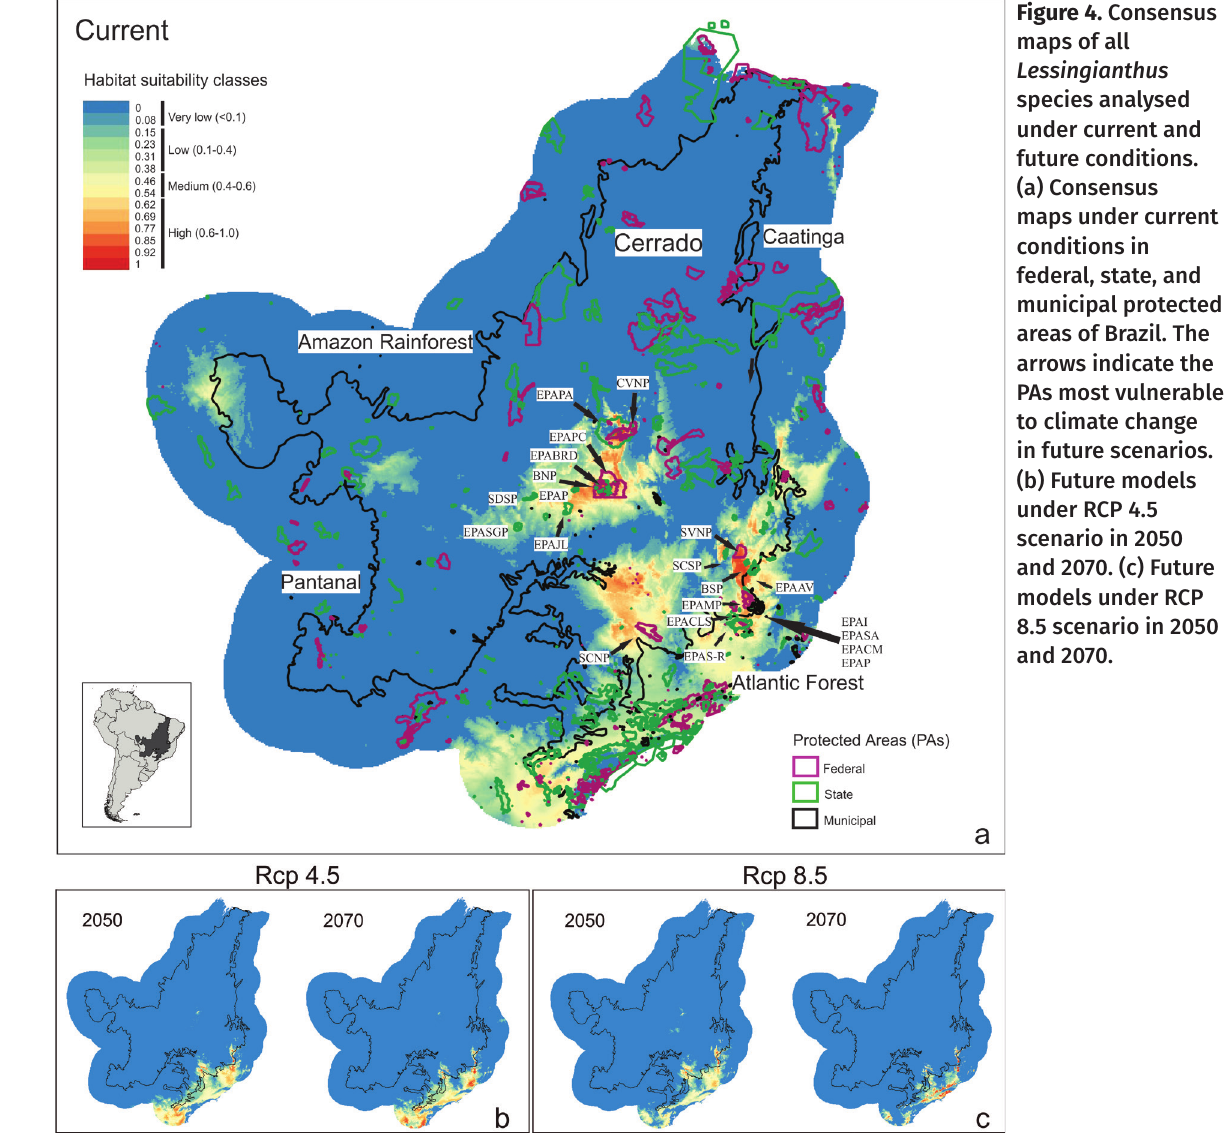
Figure 4. Consensus maps of all Lessingianthus species analysed under current and future conditions. (a) Consensus maps under current conditions in federal, state, and municipal protected areas of Brazil. The arrows indicate the PAs most vulnerable to climate change in future scenarios. (b) Future models under RCP 4.5 scenario in 2050 and 2070. (c) Future models under RCP 8.5 scenario in 2050 and